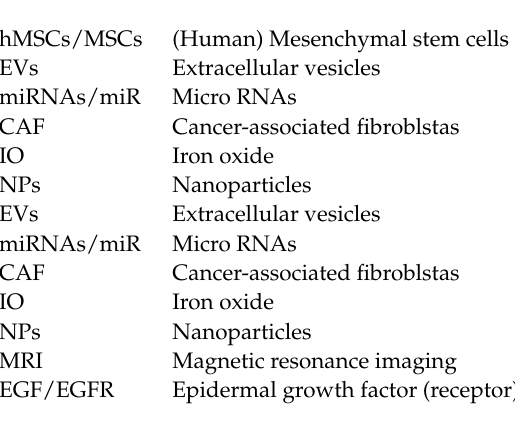
Figure S2: Effect of CD9 overexpression in B16F10 cell